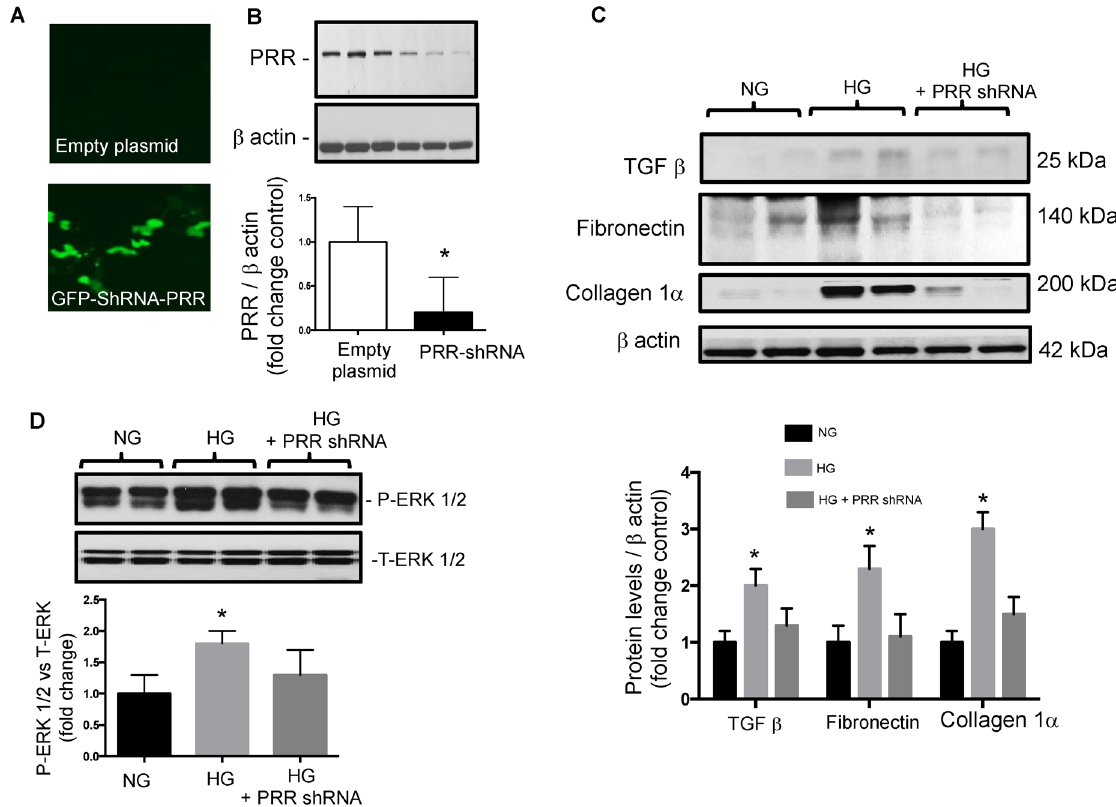
Figure 9. High glucose increases ERK pathway and fibrotic factors via PRR in M-1 cells. ( A ) M-1 cells were transfected with a green fluorescent protein (GFP)-shRNA PRR GFP or an empty plasmid as a control. ( B ) Representative immunoblot showing that shRNA PRR reduced PRR protein levels by 83% as compared to cells transfected with an empty plasmid (n = 7). ( C ) Representative immunoblots and densitometric analysis of TGF β, collagen 1α and fibronectin protein levels after 6 h of incubation with normal (NG), high glucose (HG) and HG conditions plus PRR knockdown (n = 4). No differences in TGF-β, collagen 1α and fibronectin protein levels were observed in NG conditions in cells transfected with shRNA-PRR as compared to controls (data not shown). The β-actin was used as a housekeeping protein. ( D ). Phospho-ERK (P-ERK) intensity versus total ERK (T-ERK) represented as fold change of control demonstrated the increased ratio between P-ERK and T-ERK in HG conditions (10 min) that was partially prevented by shRNA PRR transfections (n = 4). *P < 0.05 versus NG